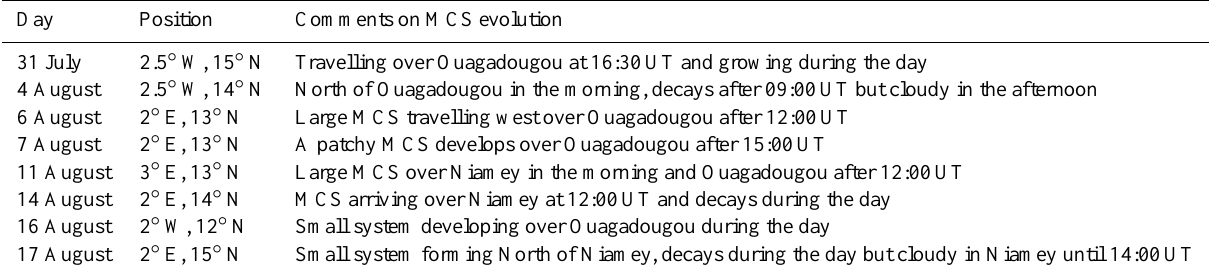
Table 3. List of Mesoscale Convective System (MCS) derived from Meteosat satellite observations near Niamey and Ouagadougou.